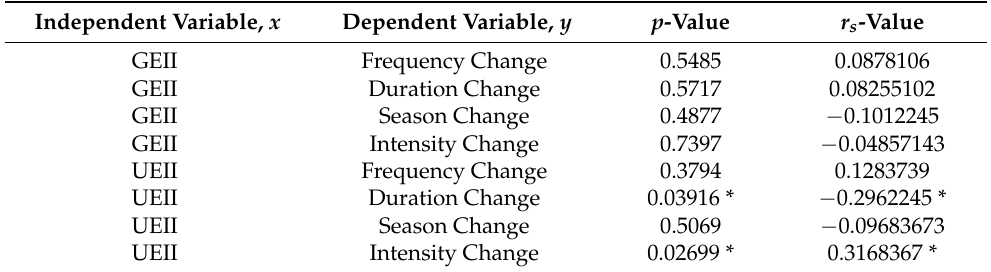
Table 10. Spearman correlation between UEII, GEII, and heatwave frequency, duration, season, and intensity for 49 cities in the U.S.